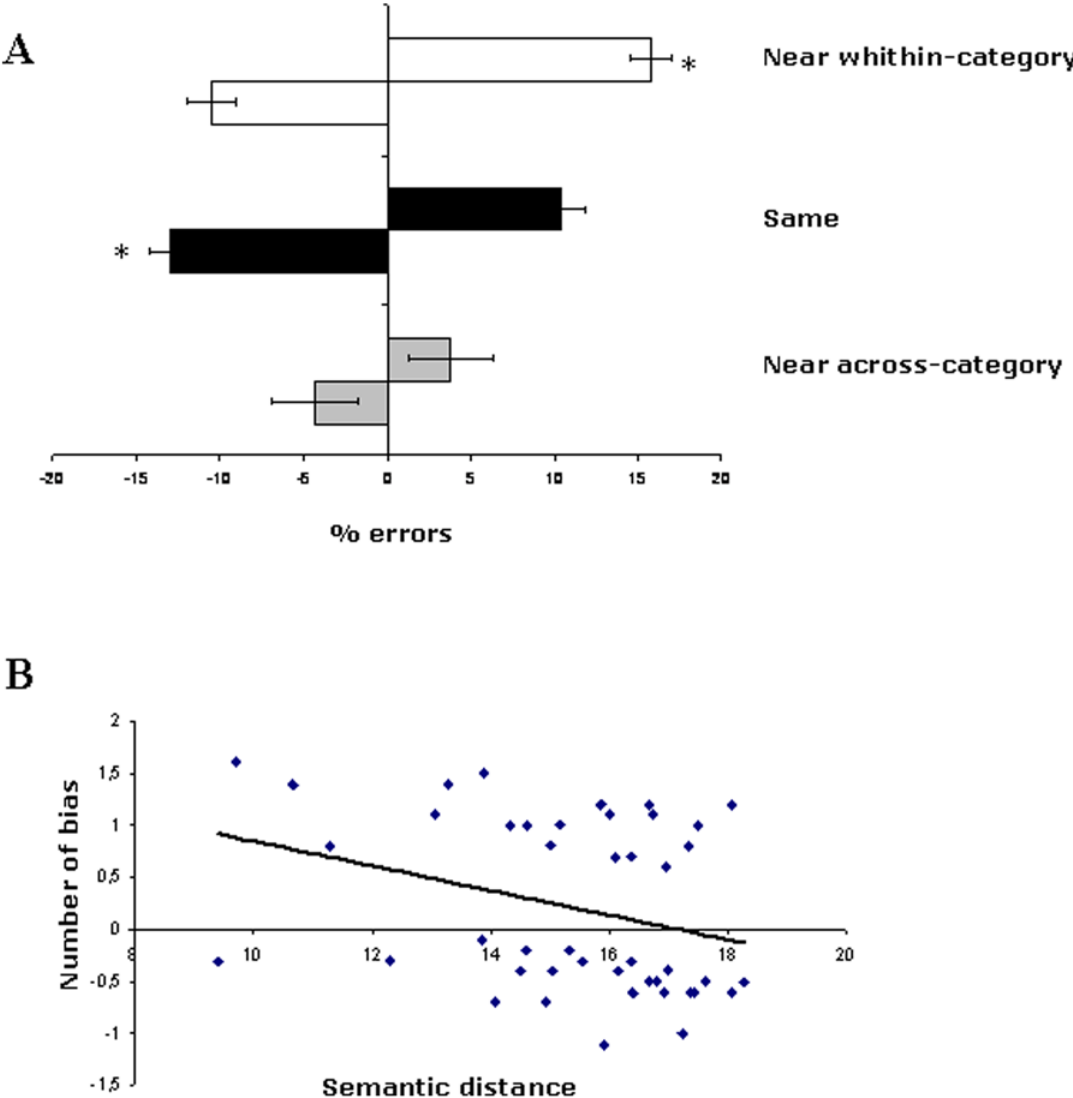
Figure 2. Experiment 1: Semantic distance judgment task. (A) Mean leftward and rightward errors ( 6 1 SE) as a function of the different experimental conditions. Negative values indicate leftward shifts and positive values rightward shifts in the judgment; (B) Bias in this experiment as a function of the semantic distance in the semantic distance judgment task. Rightward bias decreased as the magnitude of the semantic distance increased.